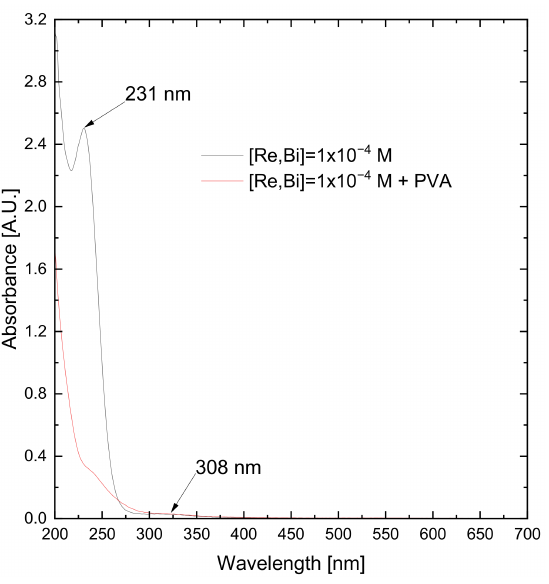
Figure 6. UV–Vis spectra of solutions of synthesized rhenium–bismuth nanoparticles in the presence and absence of a stabilizer (PVA), at both rhenium and bismuth concentrations of 1 × 10 − 4